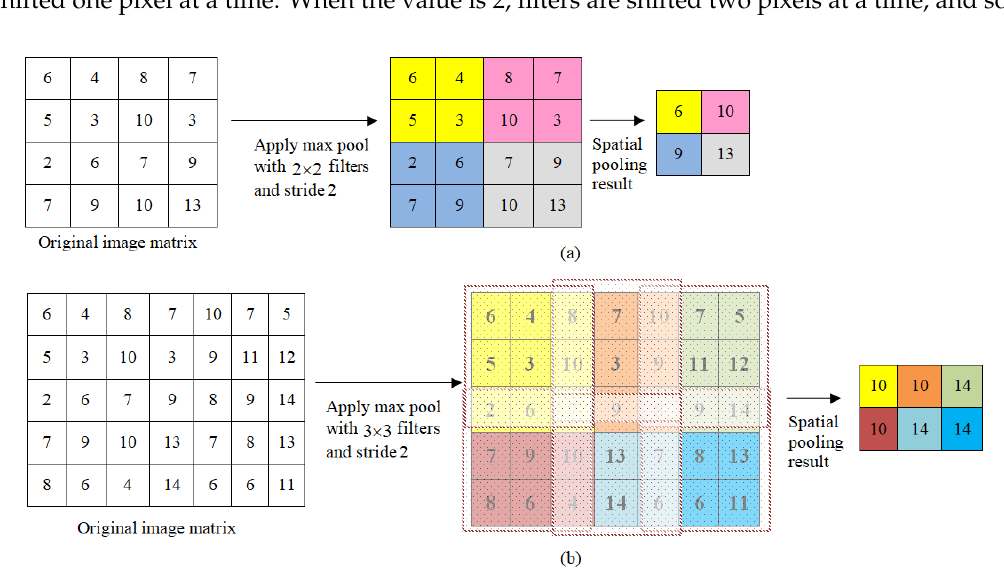
Figure 5. Max-pooling with different filters and stride values: ( a ) max-pooling with 2 × 2 filters and stride of 2, and ( b ) max-pooling with 3 × 3 filters and stride of